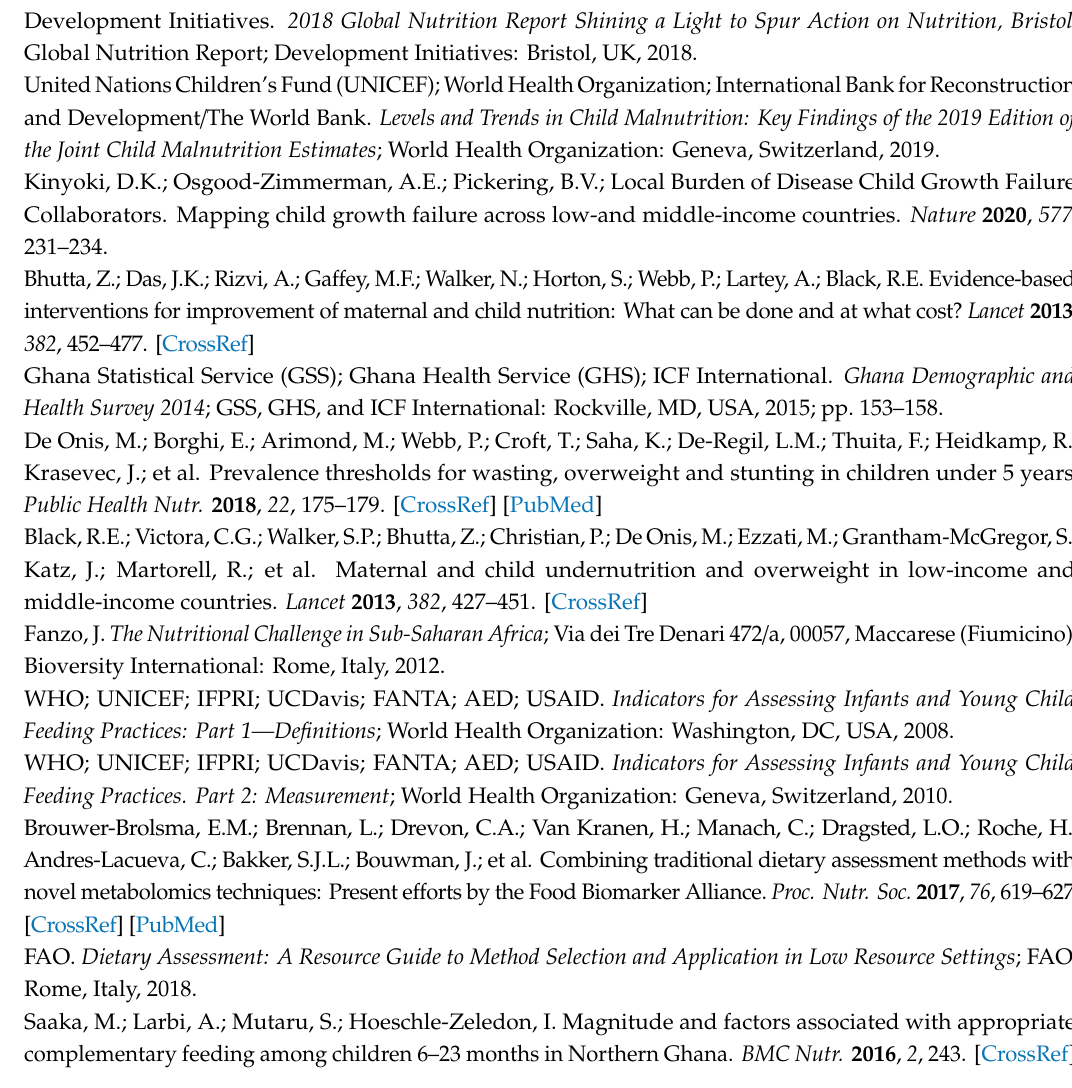
Figure S1: Illustrative Map of the Northern Region of Ghana (www.ghanaweb), Figure S2. Conceptual Framework for the Determinants of Malnutrition (Undernutrition) in northern Ghana (Adopted and modified from Bhutta et al., 2013, Fanzo, 2012 and Muller and Krawinkel, 2005), Table S1: Socio-demographic and Household Characteristics n = 581, Table S2: Bivariate analysis of the association between factors and stunting (LAZ), Table S3: Bivariate analysis of the association between WHO IYCF indicators and Wasting, Table S4: Bivariate analysis of the association between factors and